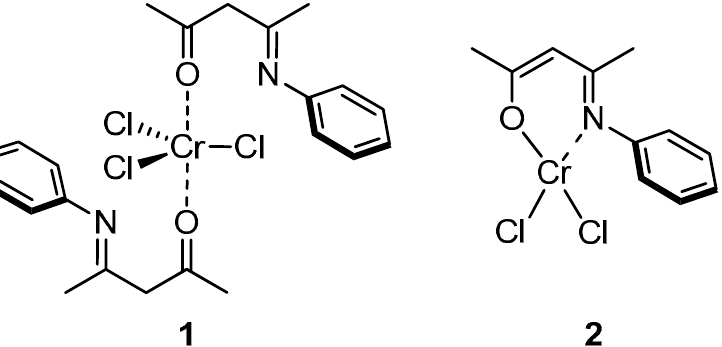
Figure 4. Schematic representation of the molecular structure of the two Cr-based ketoiminato complexes, as determined by ATR-IR spectroscopy coupled with elemental analysis. The C=N and C=O bonds have been localized according to the IR results. Full lines indicate covalent bonds, while dashed and dotted bonds indicate ionic interactions of decreasing strength.